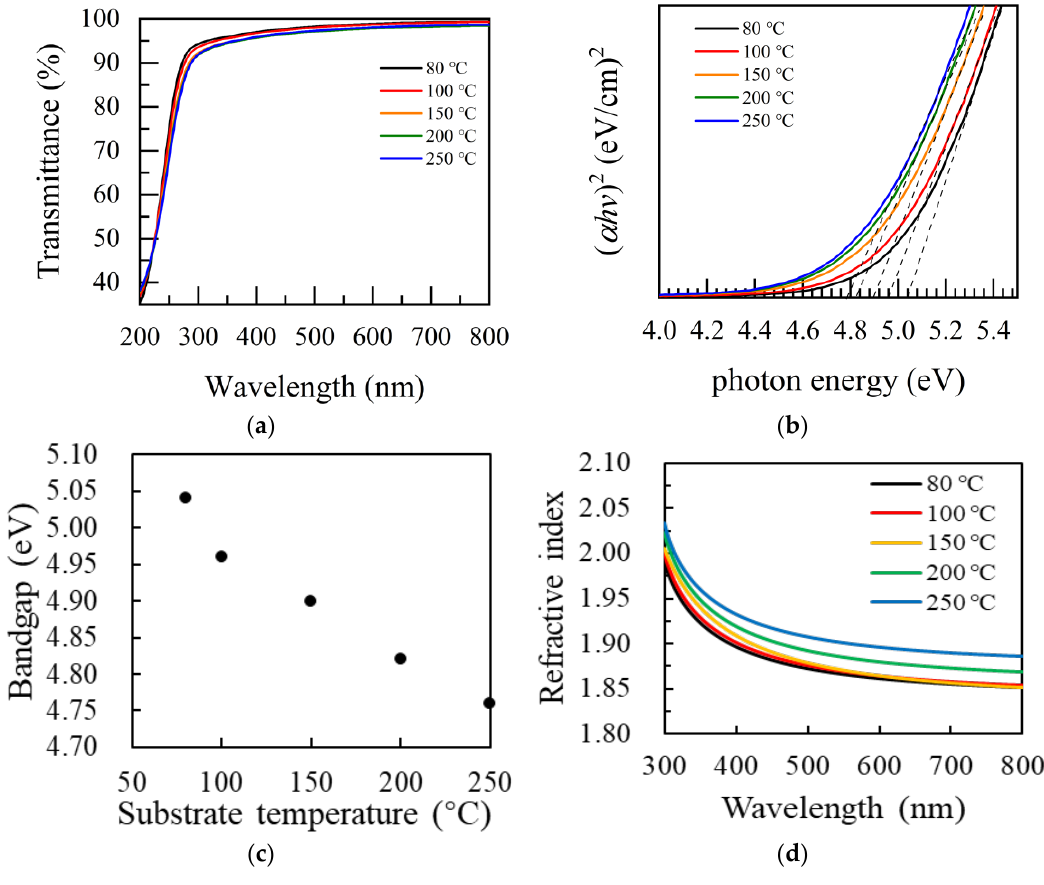
Figure 6. ( a ) Transmittance spectra of Ga 2 O 3 prepared under various deposited temperatures. ( b ) Plots of ( α h ν ) 2 as a function of photon energy ( h ν ); ( c ) Variation of the optical bandgap with the substrate temperature; ( d ) SE model results of the refractive index as a function of deposition temperature for Ga 2 O 3